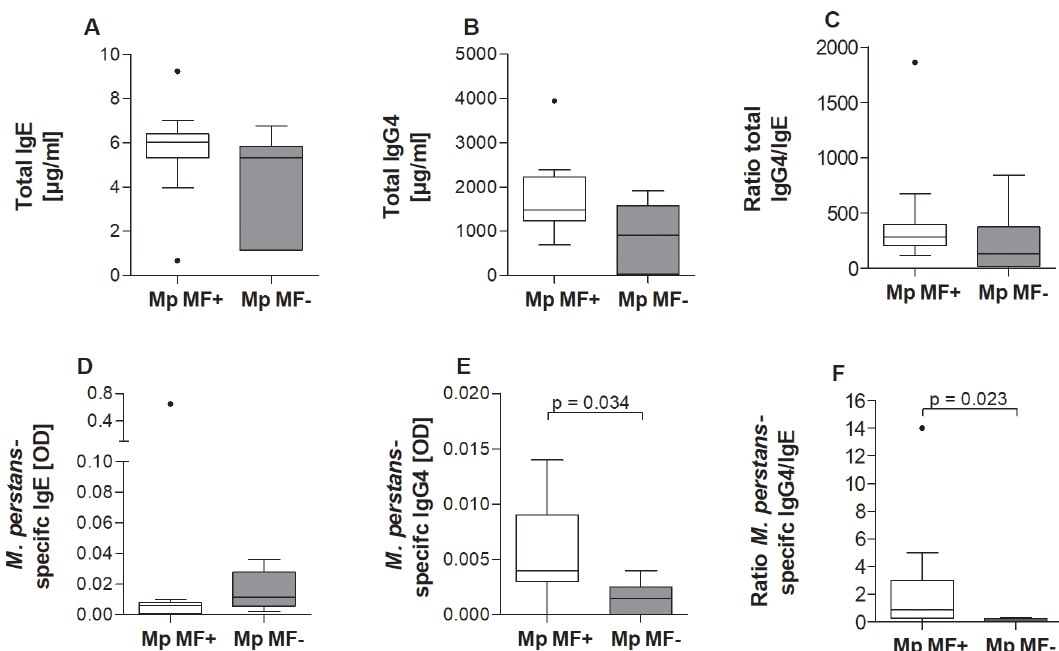
Fig 3. M . perstans microfilaremic individuals present elevated filarial-specific IgG4 in sera. Sera from and M . perstans microfilaremic (Mp MF+, n = 11) and amicrofilaremic (Mp MF-; n = 6) individuals were analyzed for total and M . perstans -specific immunoglobulin levels. ( A ) total IgE ( μ g/ml) ( B ) total IgG4 ( μ g/ml), ( C ) ratio of total IgE/IgG4, ( D ) M . perstans -specific IgE (OD), ( E ) M . perstans -specific IgG4 (OD) and ( F ) ratio of M . perstans -specific IgG4/IgE. Graphs show box whiskers with median, interquartile ranges and outliers. Statistical significances between the indicated groups were obtained using the Mann-Whitney-U- test.